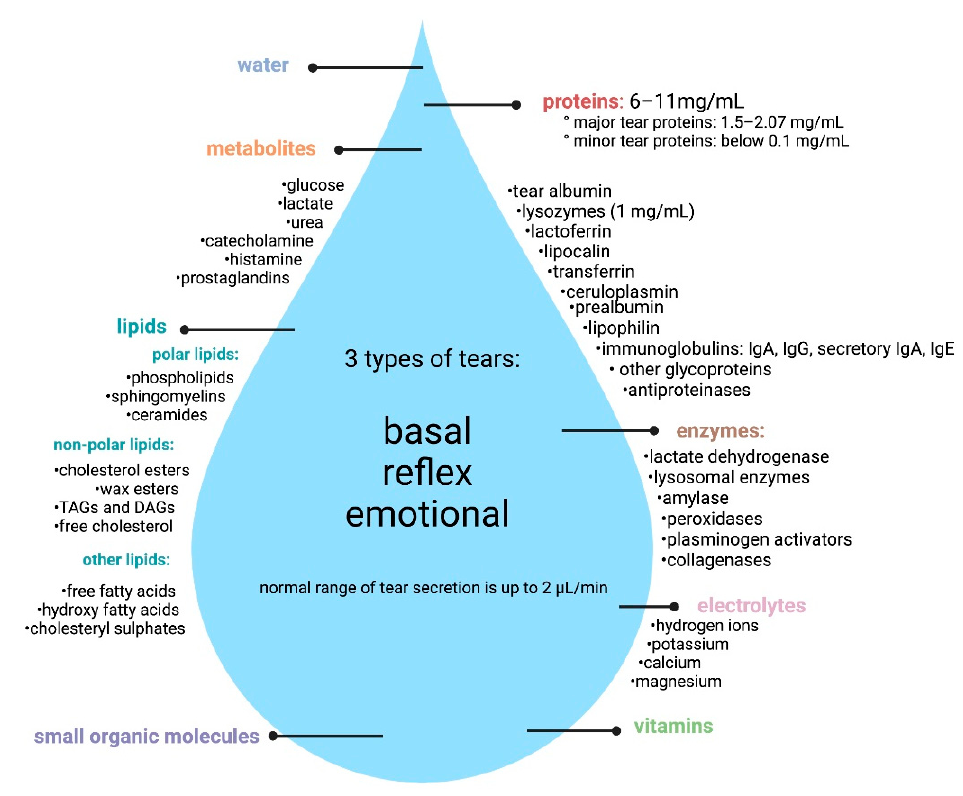
Figure 1. Tear composition (created with BioRender.com, accessed on 25 July 2022).